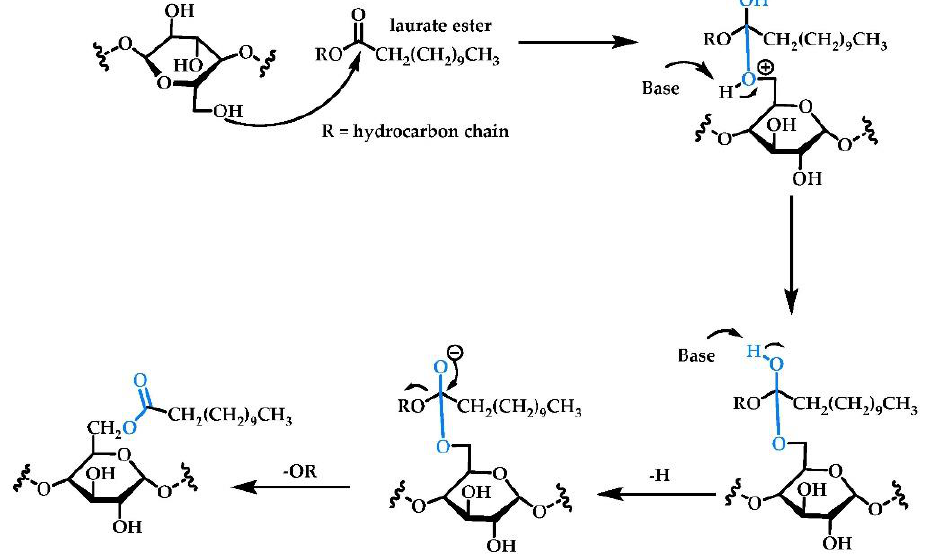
Figure 2. Transesterification of